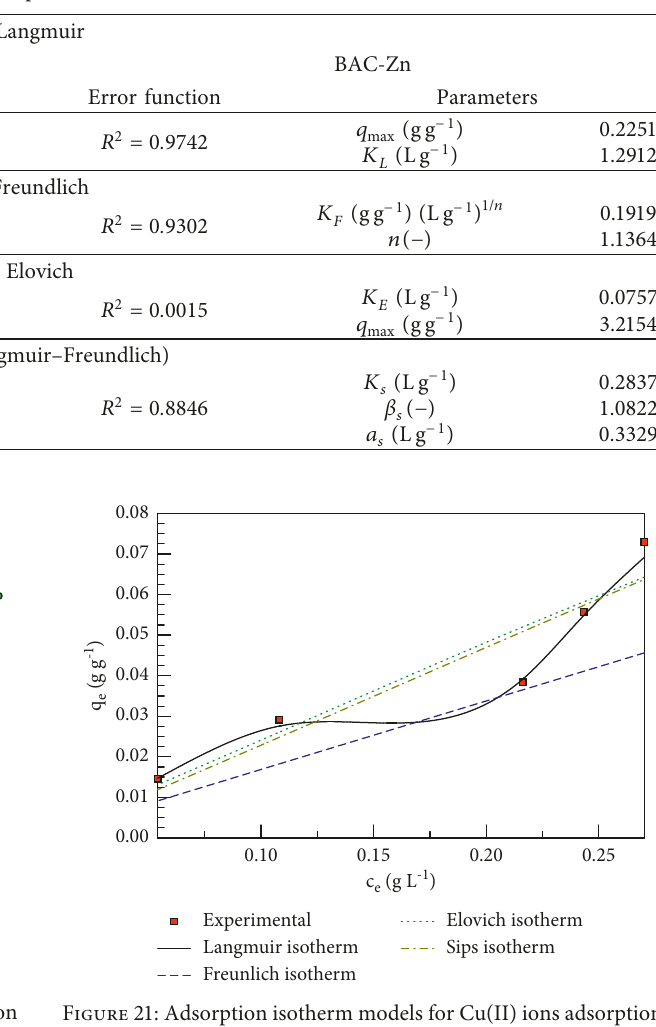
Table 7: Adsorption isotherm parameters for the adsorption of Cu(II) ions onto BAC-P and BAC-Zn adsorbents.